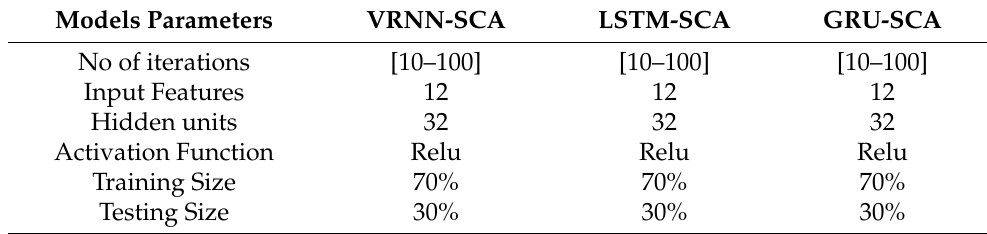
Table 4. Parameter settings and model